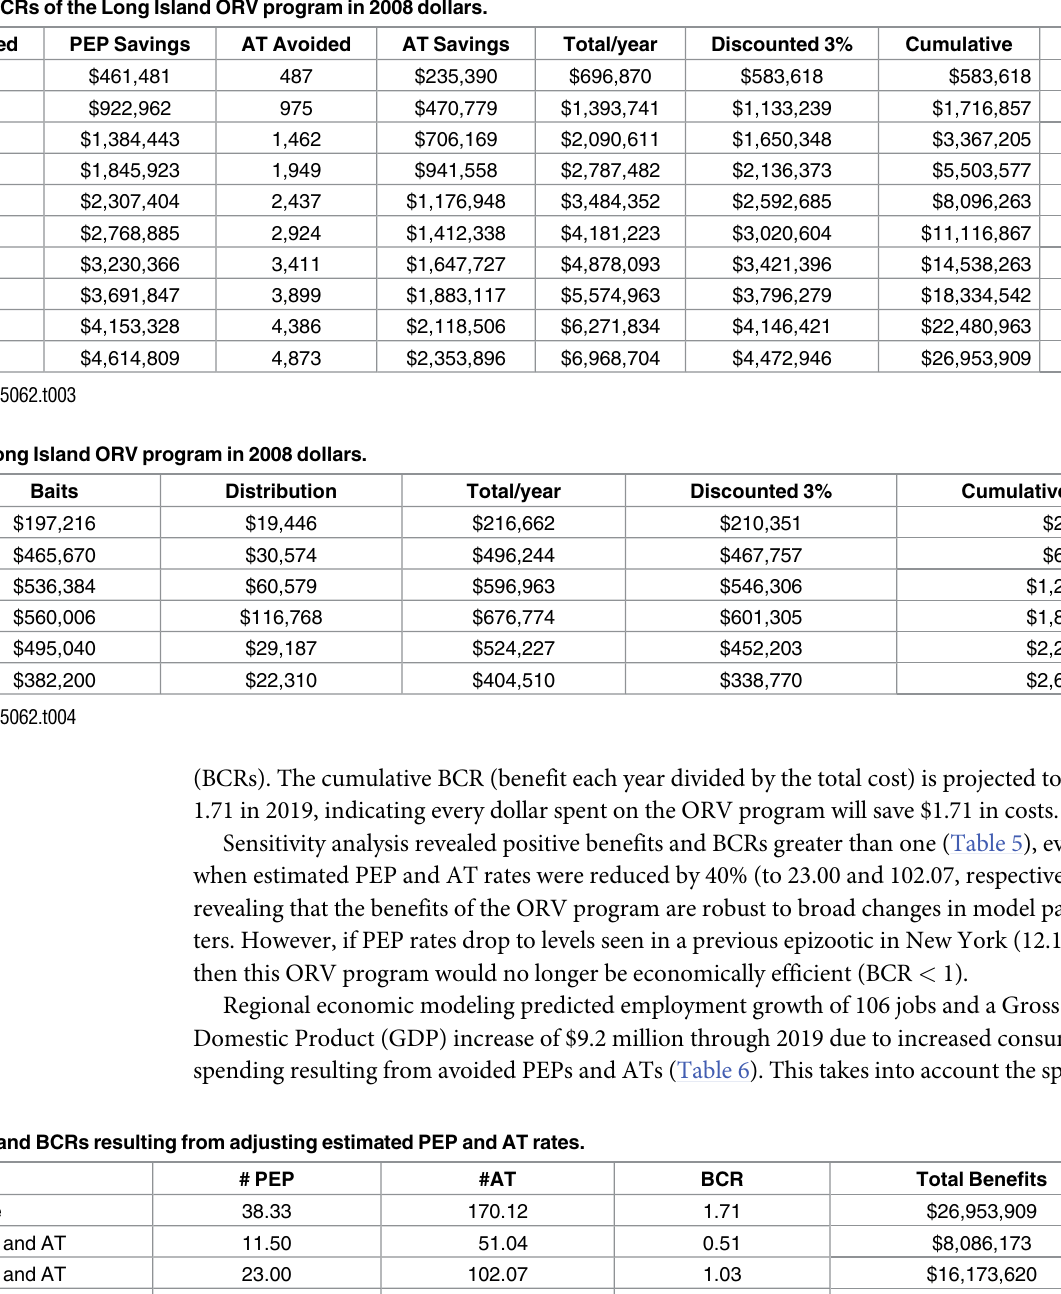
Table 3. Benefits and BCRs of the Long Island ORV program in 2008dollars.